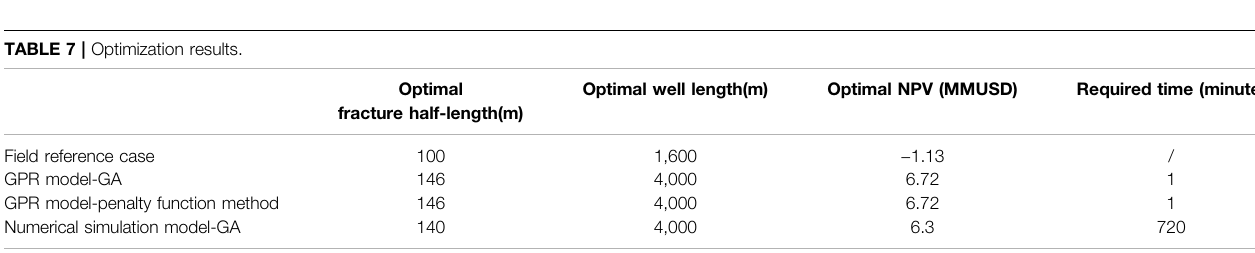
TABLE 7 | Optimization